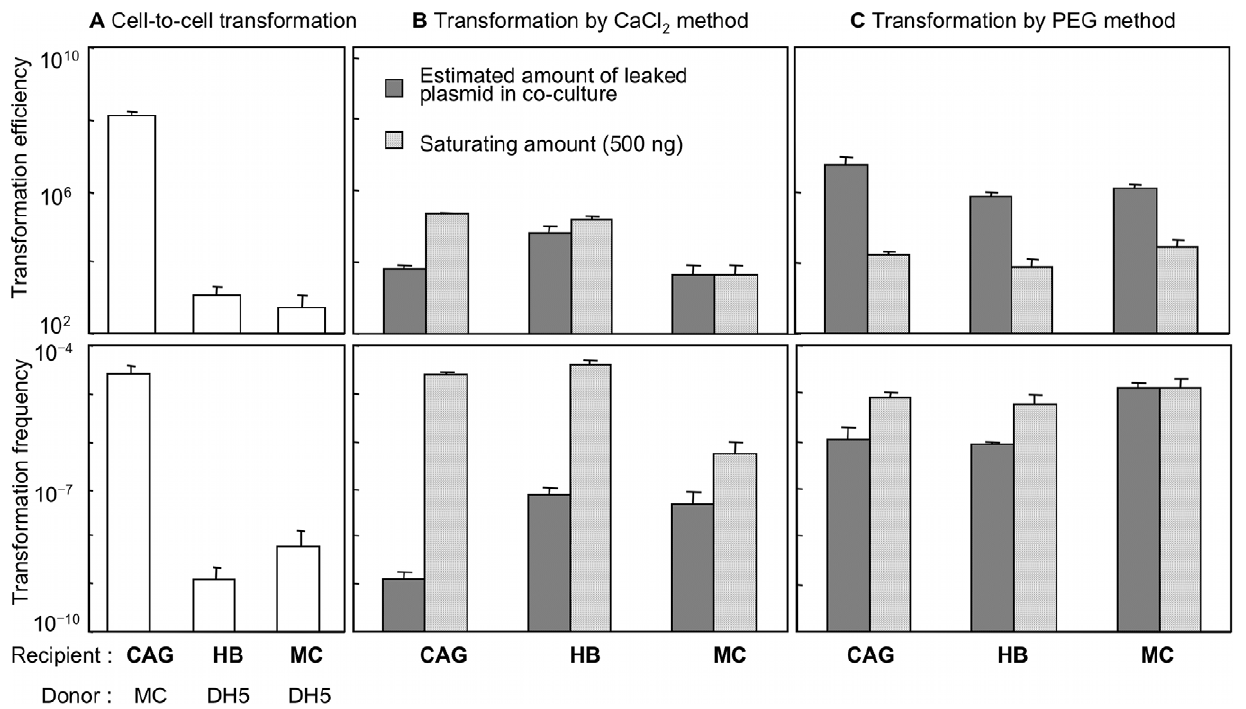
Figure 2. Comparison of cell-to-cell transformation with artificial transformation. Strain names: CAG, CAG18439; HB, HB101; and MC, MC4100. Cell-to-cell transformation (A) was performed with three combinations including donor cells harbouring pHSG299. Artificial transformations by the CaCl 2 method (B) and PEG method (C) was performed as described in Methods. In artificial transformation, plasmid (pHSG299) was used in a semi-saturating amount (500 ng/sample) or the roughly estimated amount of leaked plasmid DNA in co-culture [CAG: 2 6 10 –10 ; HB: 1 6 10 –8 ; MC: 1 6 10 –9 ng per recipient (=competent) cells]. The latter values were calculated on the assumptions that free plasmid DNA was supplied from dead donor cells (maximum 5% of total population) to co-existing recipient cells in each corresponding co-culture of cell-to-cell transformation, and that the pHSG299 copy number is , 200 per cell [38]. Transformation frequency and transformation efficiency were calculated as described in Methods. Data are presented as mean and S.D. ( n =3). doi:10.1371/journal.pone.0016355.g002 PLoS ONE |